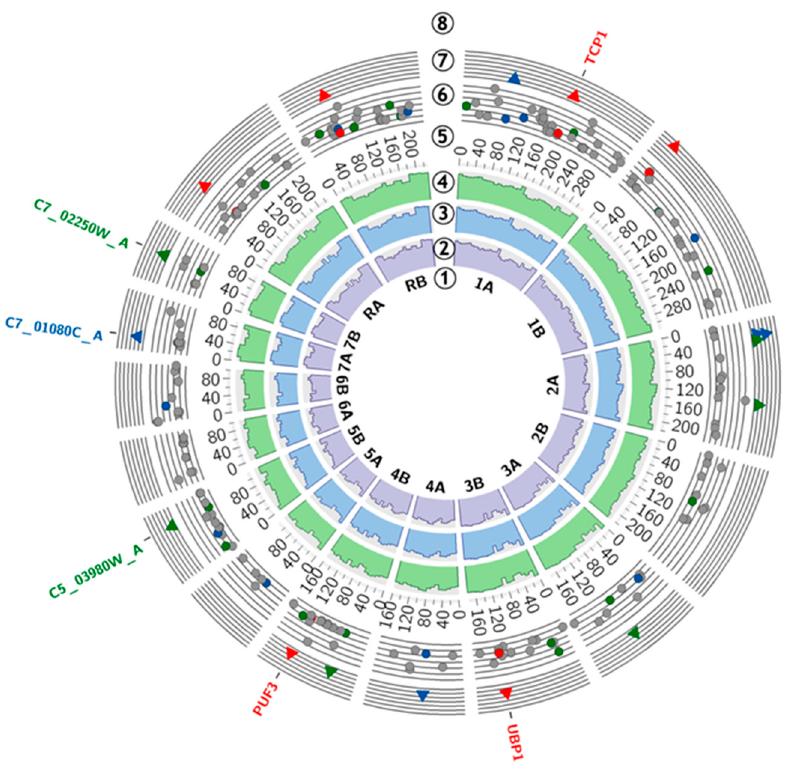
Figure 2. Genome diagram: ( 1 ) C. albicans SC5314 A22 ideogram; ( 2 ) control sample coverage; ( 3 ) 12_1 sample coverage; ( 4 ) 12_2 sample coverage; ( 5 ) chromosomal coordinates; ( 6 ) genomic alternations (grey—low confidence single nucleotide variants (SNVs), red—high confidence SNVs, blue—deletions, green—insertions); ( 7 ) genomic alternations statistically significant (red—high confidence SNVs, blue—deletions, green—insertions); ( 8 ) genes affected by high-confidence SNVs (red), deletion (blue), insertions (green).